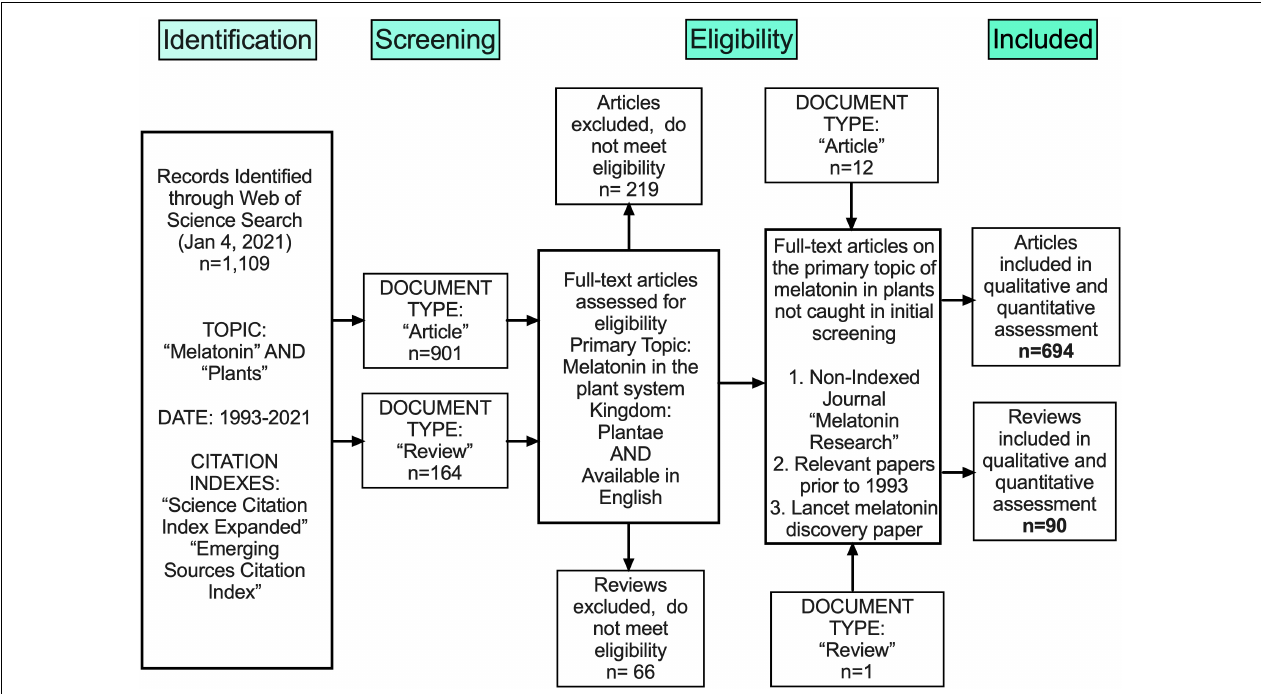
FIGURE 2 | Flow chart outlining methods of unbiased collection of literature following the PRISMA